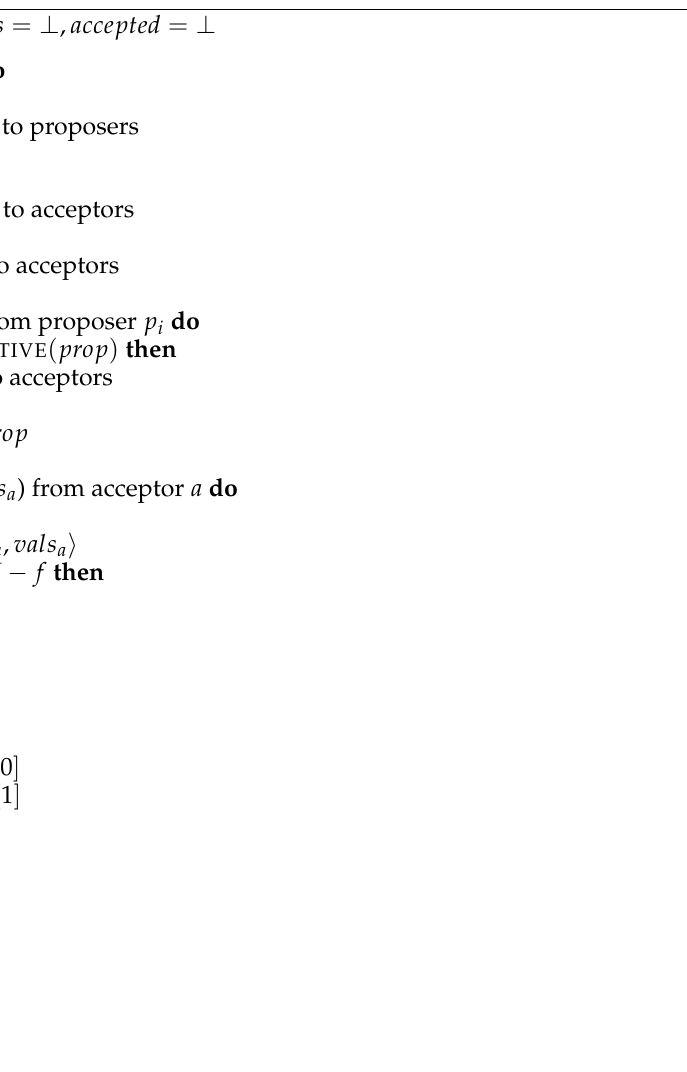
Algorithm 3 Generalized Paxos—Leader